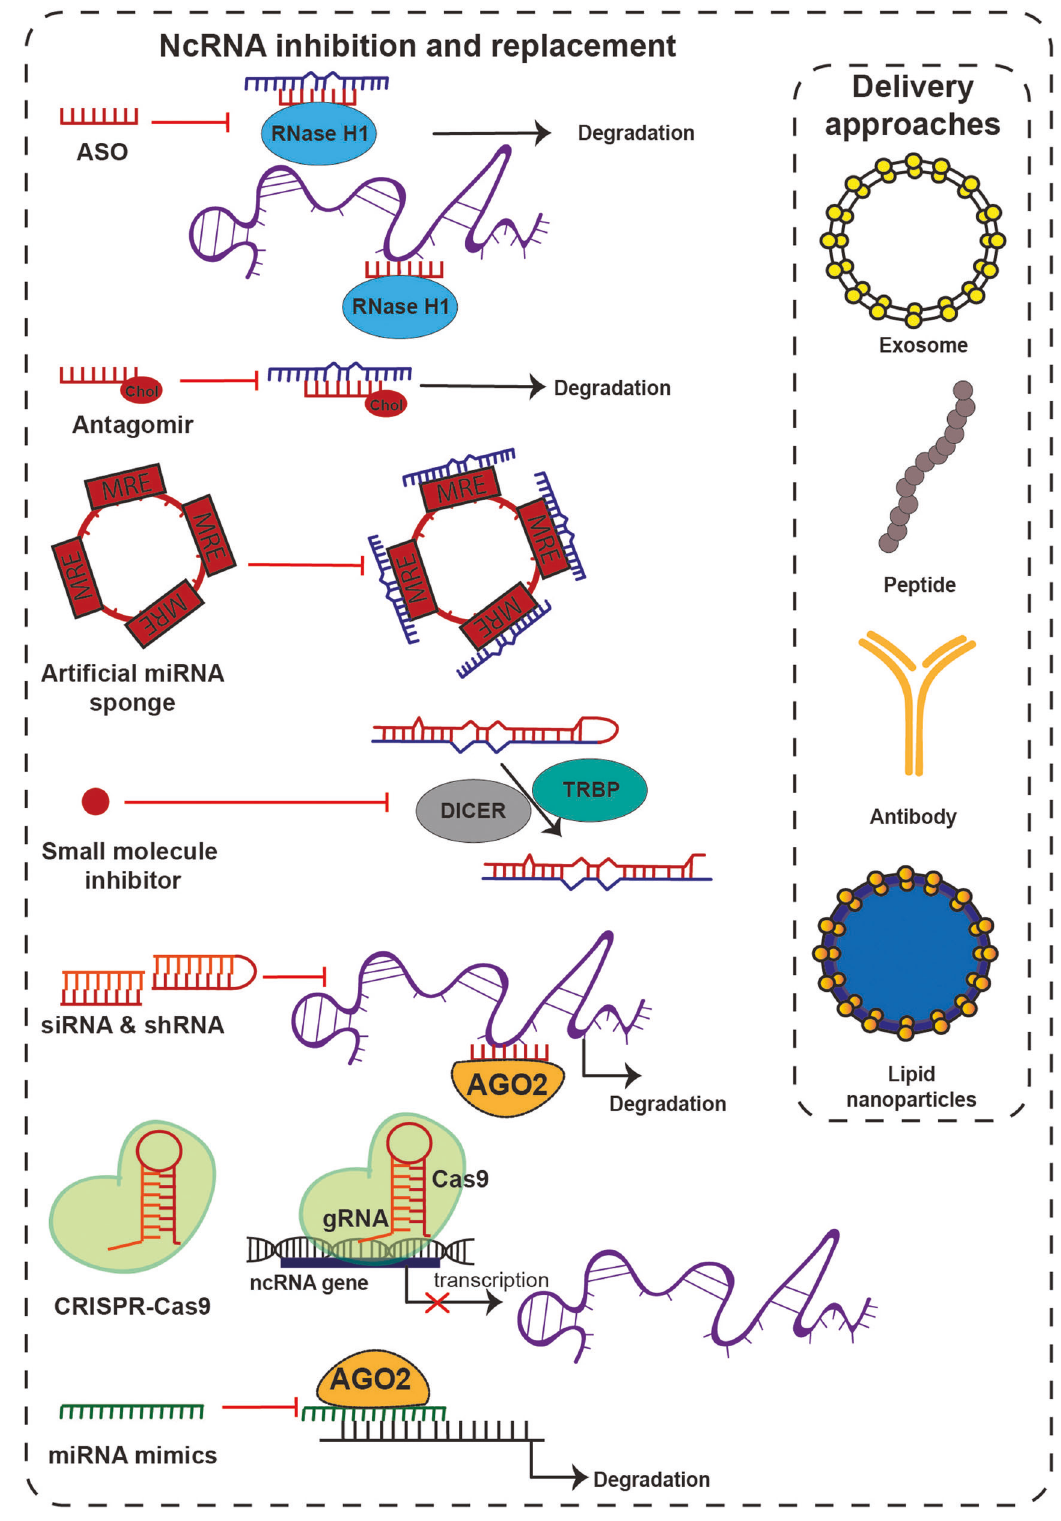
expressed in the liver, making GalNAc ideal as a liver-targeted delivery system. When conjugated together with the oligonucleo- tides or siRNAs, GalNAc facilitates the uptake of these RNA drugs into hepatocytes by endocytosis with high selectivity. 159 For example, givosiran, a GalNAc-conjugated siRNA, targets